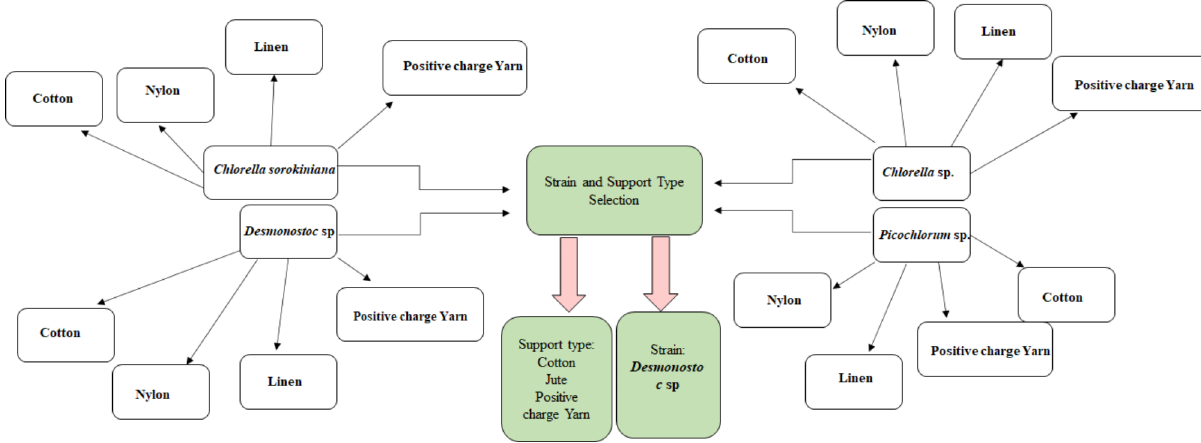
Fig. 1 Experimental design for selecting the appropriate substrate and microalgae/ cyanobacteria strains for the attached-based culture